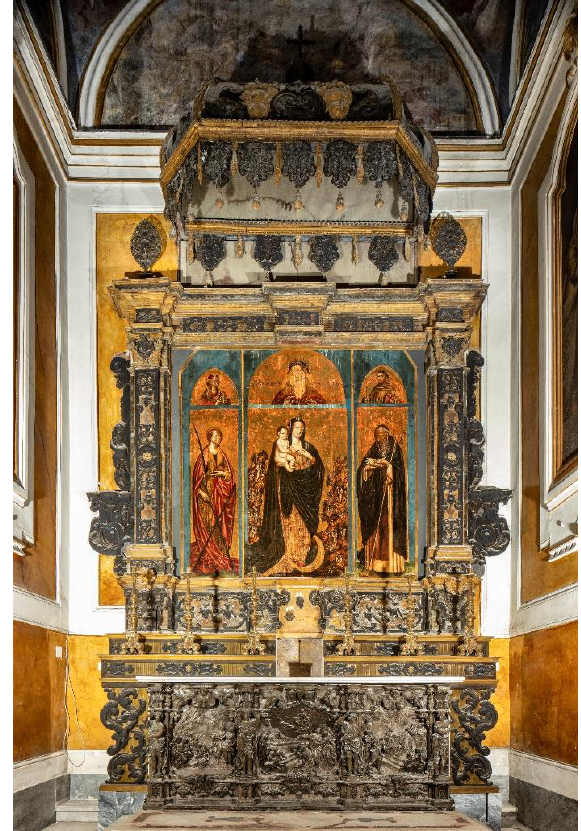
Figure 2 . The canopy, decorated by the altar silver frontal,